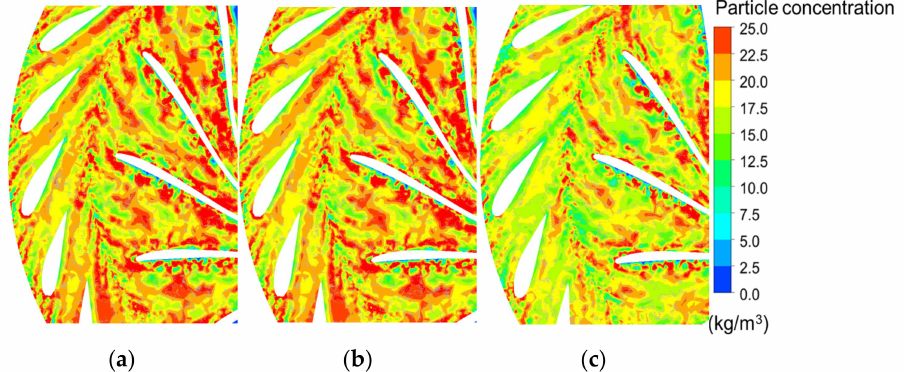
Figure 12. Volume fraction distribution of local solid phase in guide vane and runner passage: ( a ) 15 ◦ ,